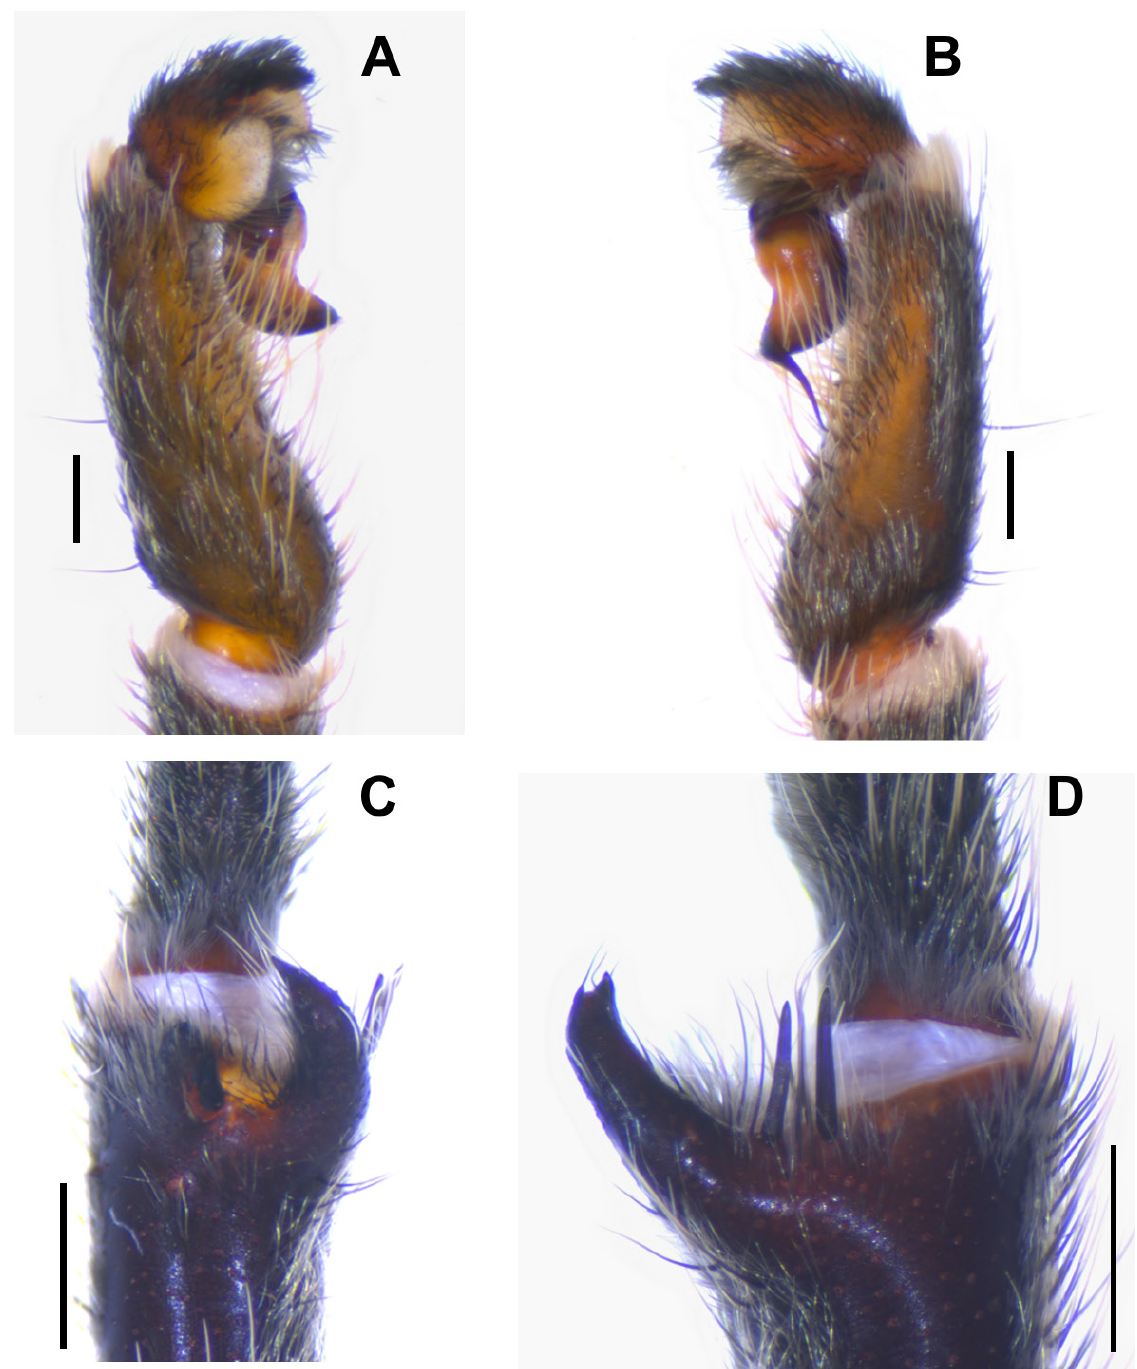
Fig. 3. Bistriopelma peyoi sp. nov., holotype, ♂ (MUBI 73). A – B . Cymbium, tibia and patella. A . Retrolateral view. B . Prolateral view. – C – D . Tibial apophysis. C . Ventral view. D . Prolateral view. Scale bars =